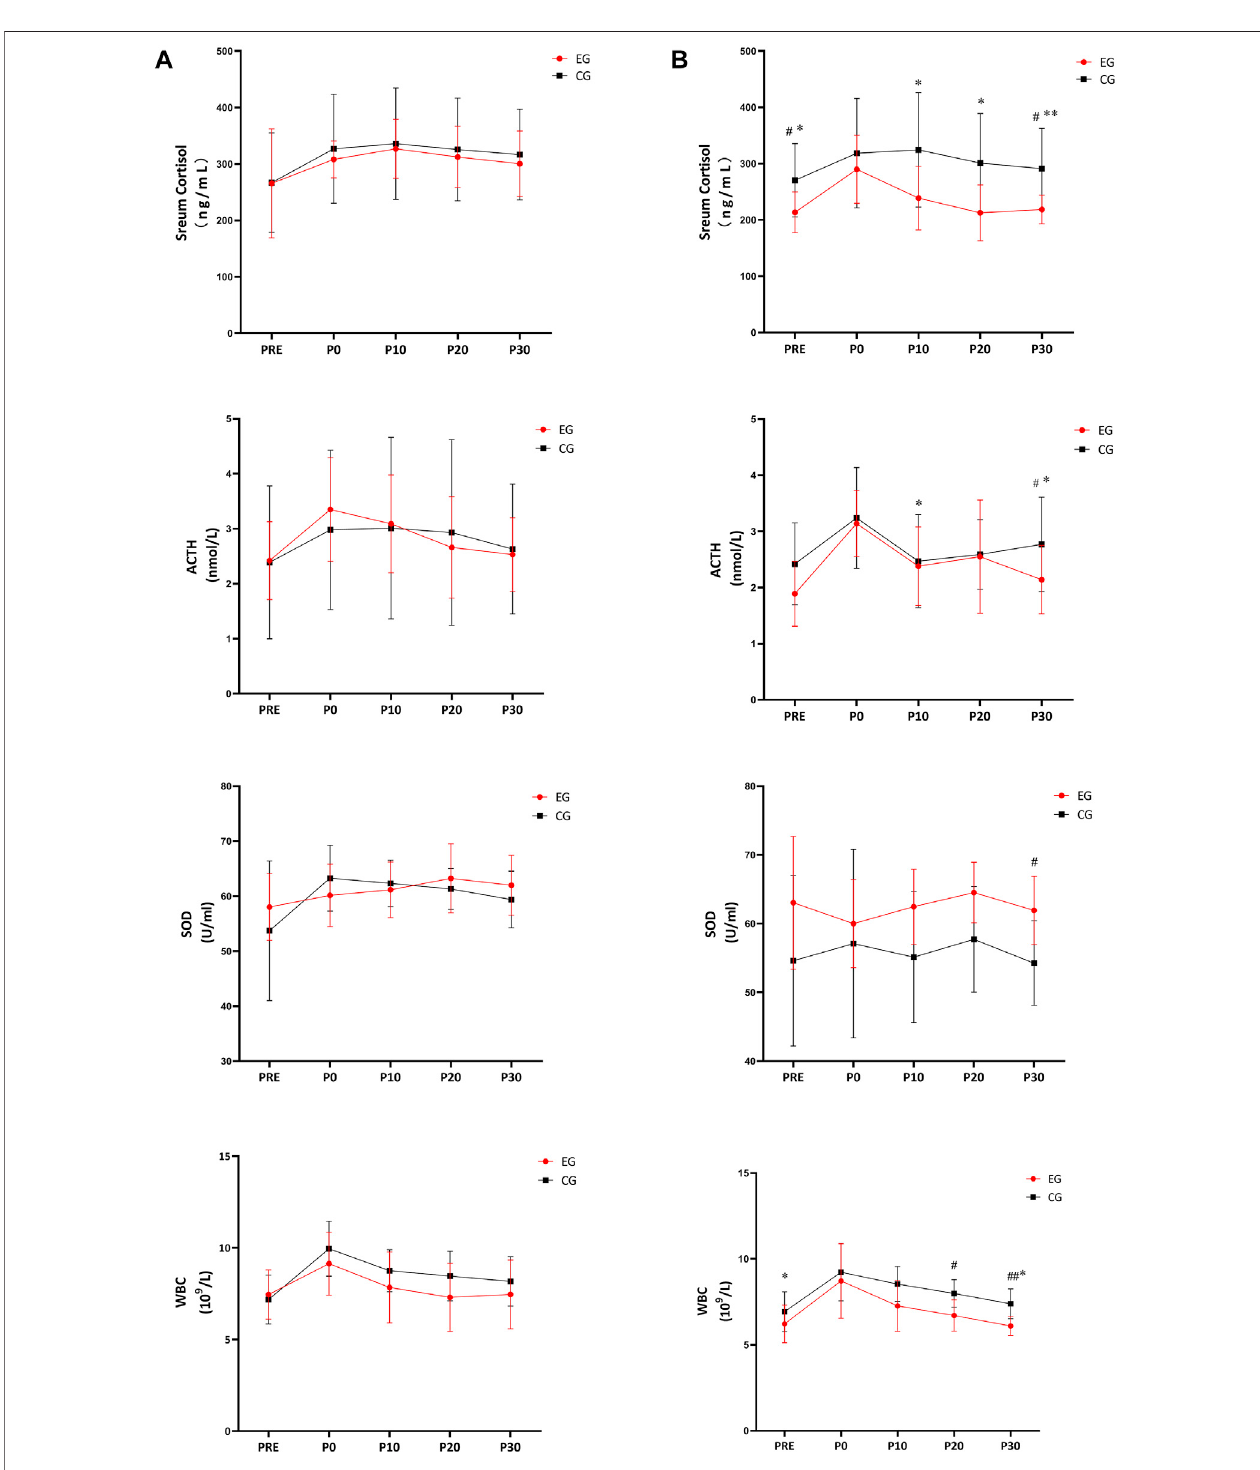
FIGURE 4 | Effects of 4-week tangeretin supplementation and high-intensity resistance exercise on serum cortisol, ACTH, SOD and WBC. Notes: (A) fi rst high- intensityresistanceexercise; (B) secondhigh-intensityresistanceexercise;CG:controlgroup;EG:experimentalgroup;# p < 0.05,EGvsCG;## p < 0.01,EGvsCG;* p < 0.05, vs. PRE; ** p < 0.01 vs